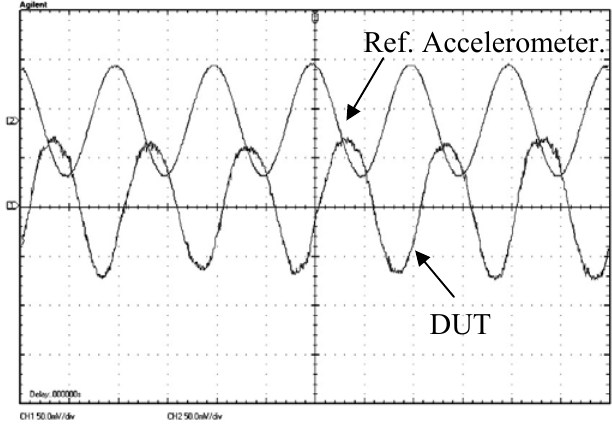
Figure 10. Output waveforms from the DUT and reference accelerometer under a 1 g sinusoidal acceleration. Both channels have the same sensitivity of 50 mV/div.(The phase shift between the two accelerometers is due to the different sensing and parasitic capacitance and readout circuit.) Ref. Accelerometer.